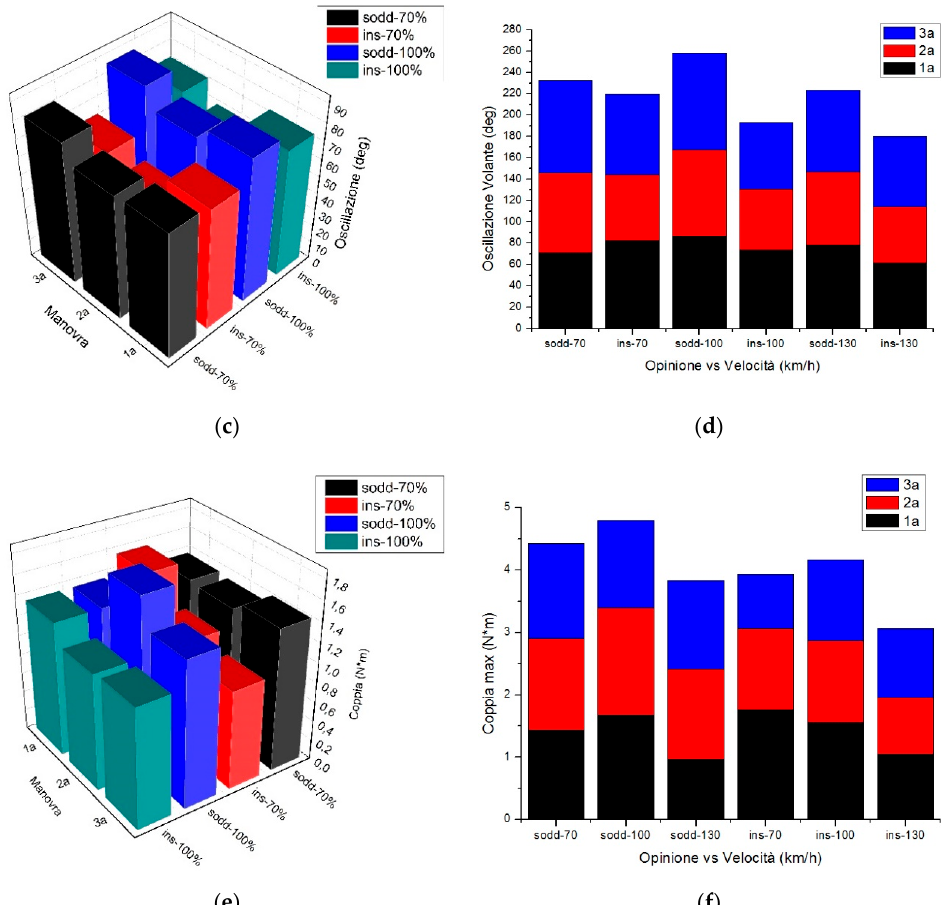
Figure A2. “Overall satisfaction” subgroups distinguished according to overall opinion.